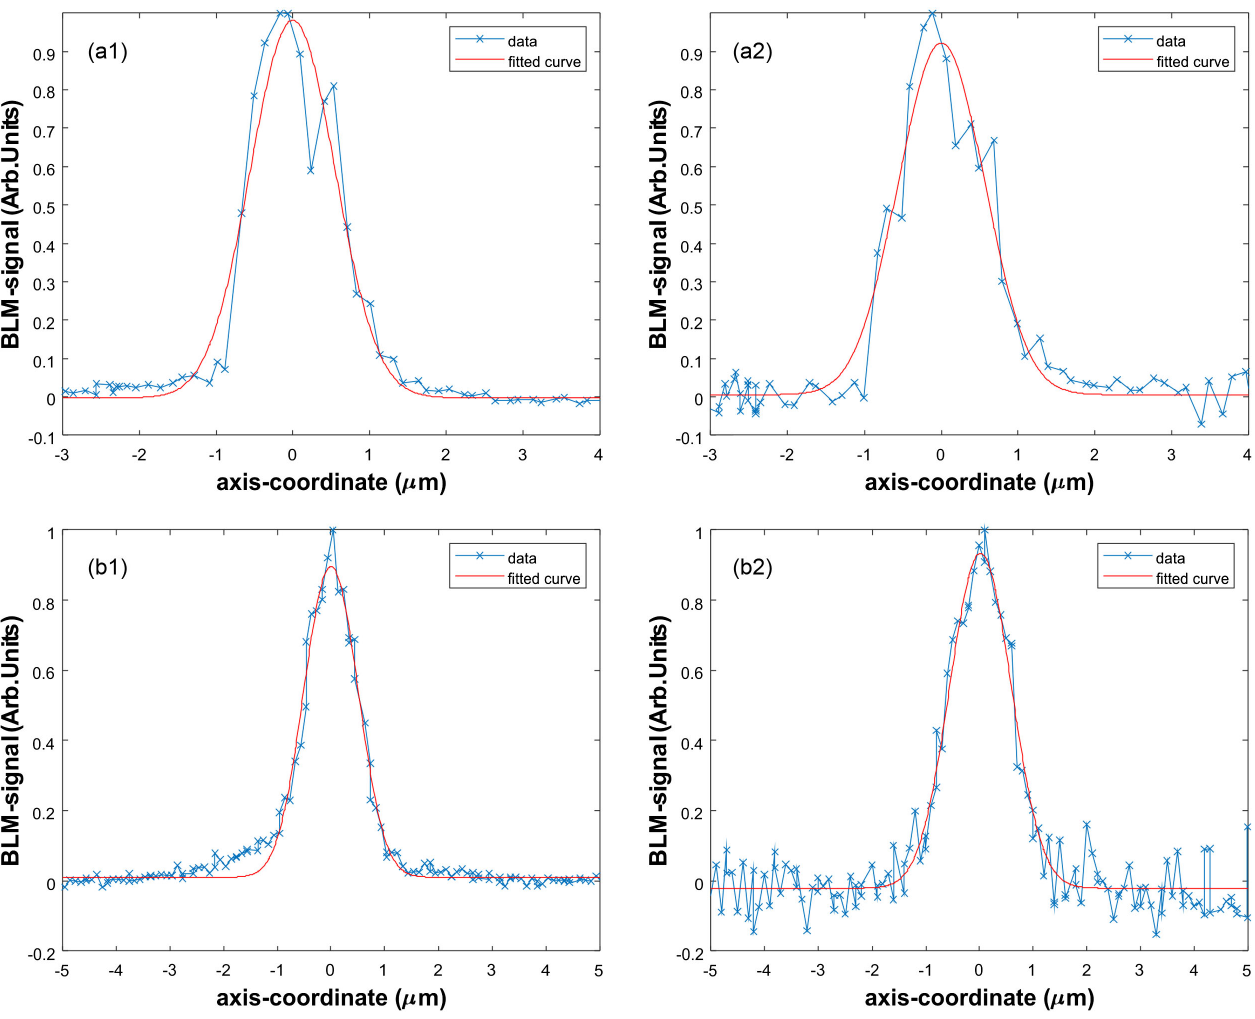
FIG. 6. Beam vertical profiles measured by means of the free-standing WS with submicrometer resolution: PSI 900 nm (a1, b1) and FERMI 800 nm (a2, b2) wide Au stripe. Measurements have been performed at SwissFEL in two different machine sessions: (a) December 4, 2018; (b) March 31, 2019. The beam profile plotted in pictures (a) is the result of the average of 5 acquisitions, while the beam profiles plotted in pictures (b) are the result of a single shot acquisition. Beam size determined by means of error-function fit, see Eq. (1) and Table